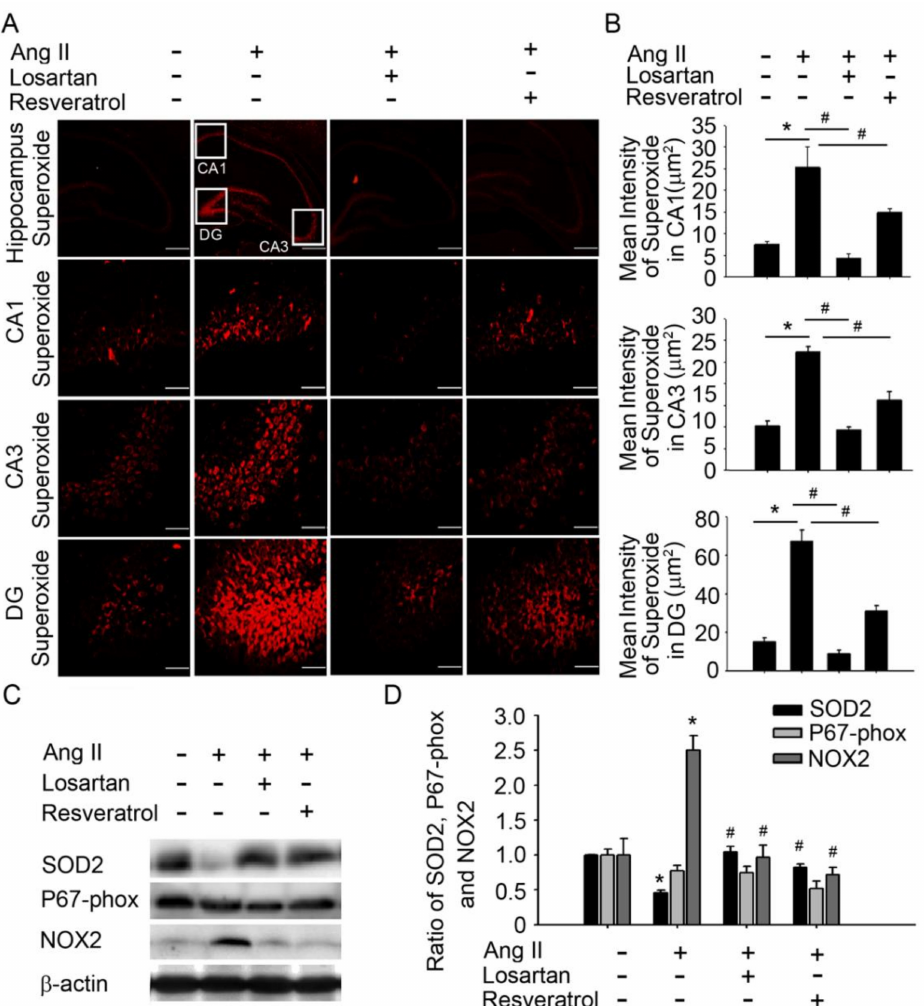
Figure 2. Resveratrol abolished superoxide and NOX2, and reduced SOD2 activity in the hippocampus of AD rats. ( A ) Confocal microscopy analysis of DHE-treated brain sections in the hippocampus after treatment with losartan or resveratrol. ( B ) Bar graph showing the superoxide production ratio after treatment with Ang-II and/or losartan or resveratrol. Note the significant decrease in Ang-II-induced superoxide production after the administration of losartan or resveratrol. ( C , D ) Quantitative immunoblot analysis demonstrating decreased expression of the NOX2 ratio in the hippocampus of Ang-II-treated rats after losartan or resveratrol treatment. The SOD2 protein level in the hippocampus was significantly increased following losartan or resveratrol treatment. The values are presented as the mean ± SEM; n = 6. * p < 0.05 vs. the WKY group. # p < 0.05 vs. the Ang-II group. NOX2, NADPH oxidase 2; SOD2, manganese superoxide